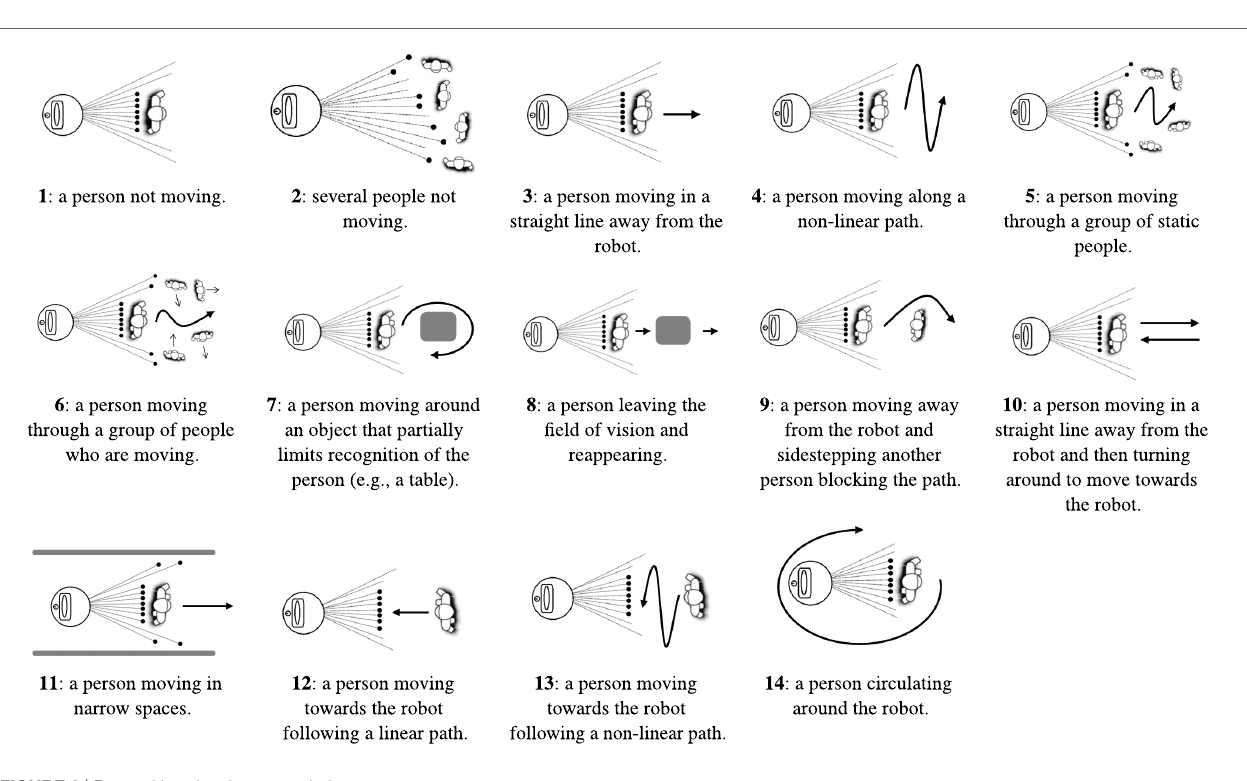
FIgURe 2 | Recognition situations